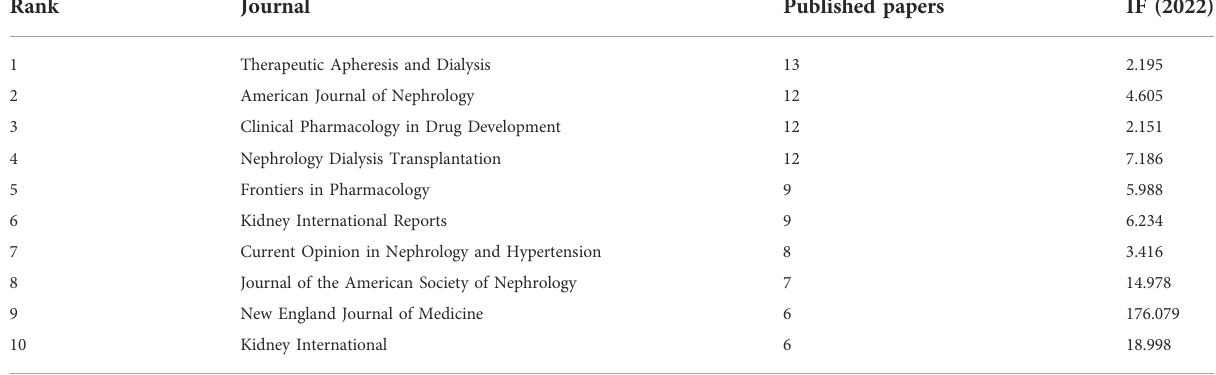
TABLE 3 Top10 journals and numbers of published